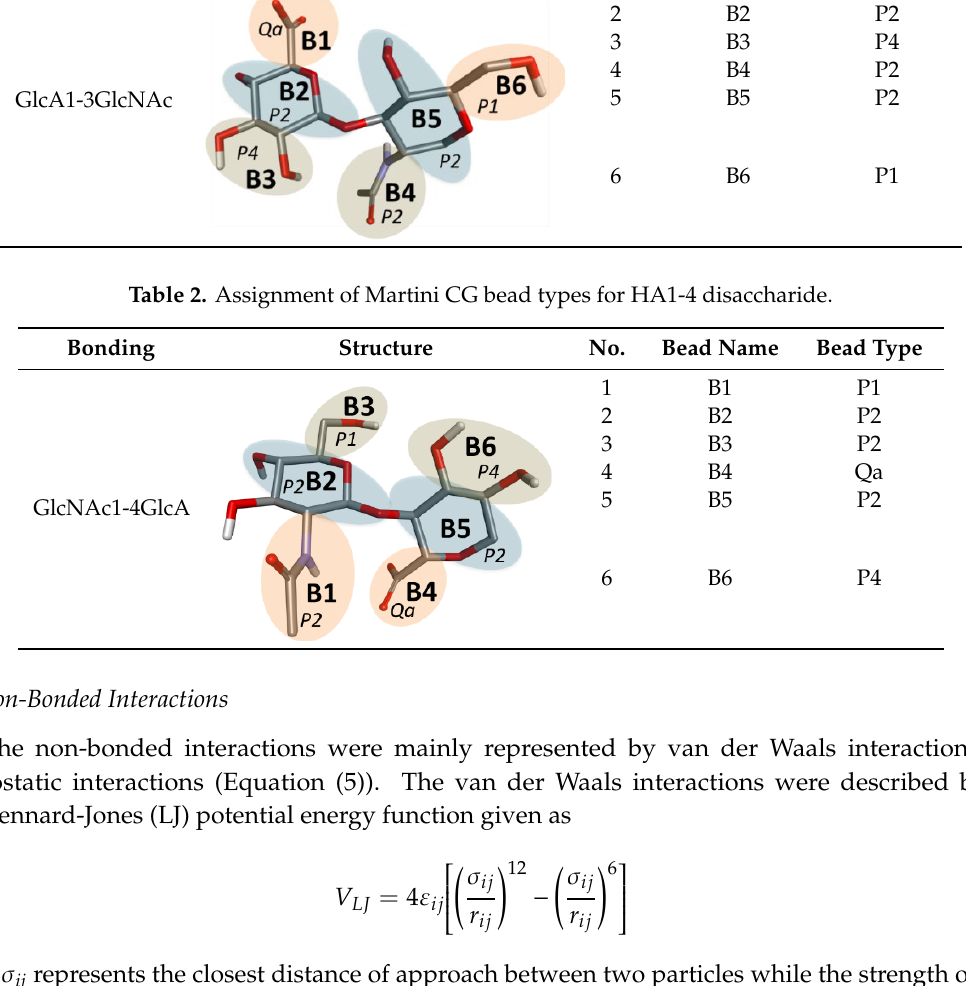
Table 1. Assignment of Martini CG bead types for the HA1-3 disaccharide.